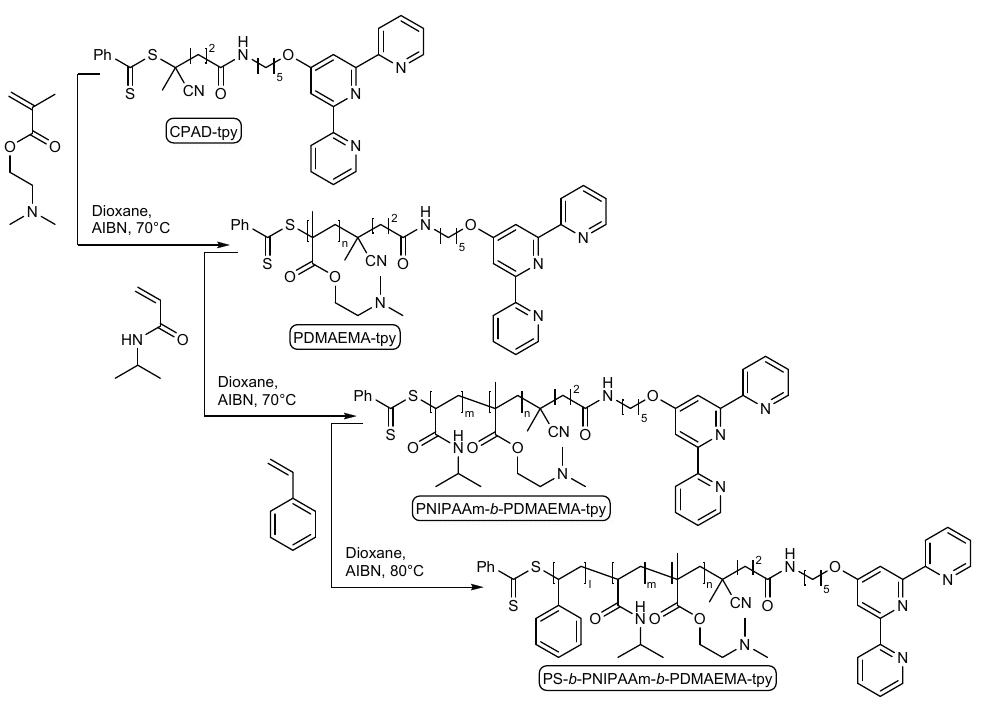
Figure 1. Sequential reversible addition-fragmentation chain transfer (RAFT) copolymerization leading to polystyrene- block -poly( N -isopropylacrylamide)- block -poly(2- (dimethylamino)ethyl methacrylate) triblock terpolymer (PS- b -PNIPAAm- b -PDMAEMA- b -tpy). CPAD, 4-(4-cyanopentanoic acid) dithiobenzoate; AIBN,